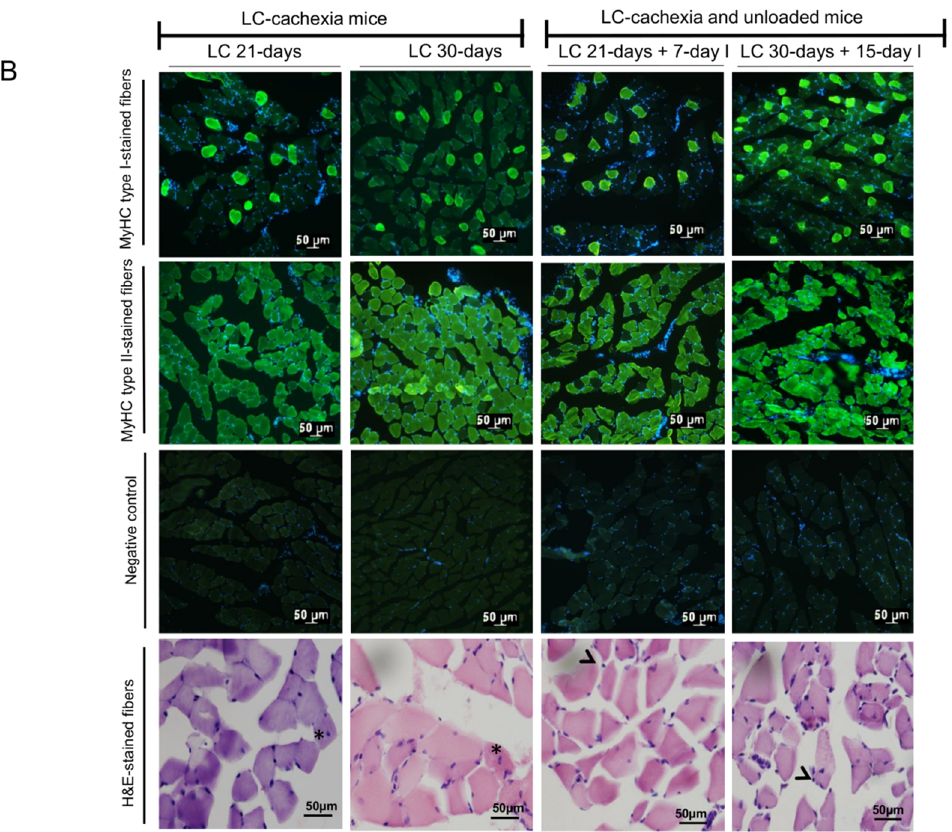
Figure 2. ( A ) Representative examples of the gastrocnemius muscle of the NI-control, 7-day I, and 15-day I groups of mice. ( B ) Representative examples of the gastrocnemius muscle of the LC 21-days, LC 30-days, LC 21-days + 7-day I, and LC 30-days + 15-day I groups of mice. Myofibers were stained in green; type I fibers (top panels), type II fibers (middle-up panels), and negative controls with no staining (middle-down panels). Hematoxylin-eosin stained muscle fibers are shown in the bottom panel. The arrowhead indicates an inflammatory cell and the asterisk points towards a fiber with an internal nucleus. Definition of abbreviations: MyHC myosin heavy chain; NI, non-immobilized; I, immobilization; H, hematoxylin; E, eoxin.